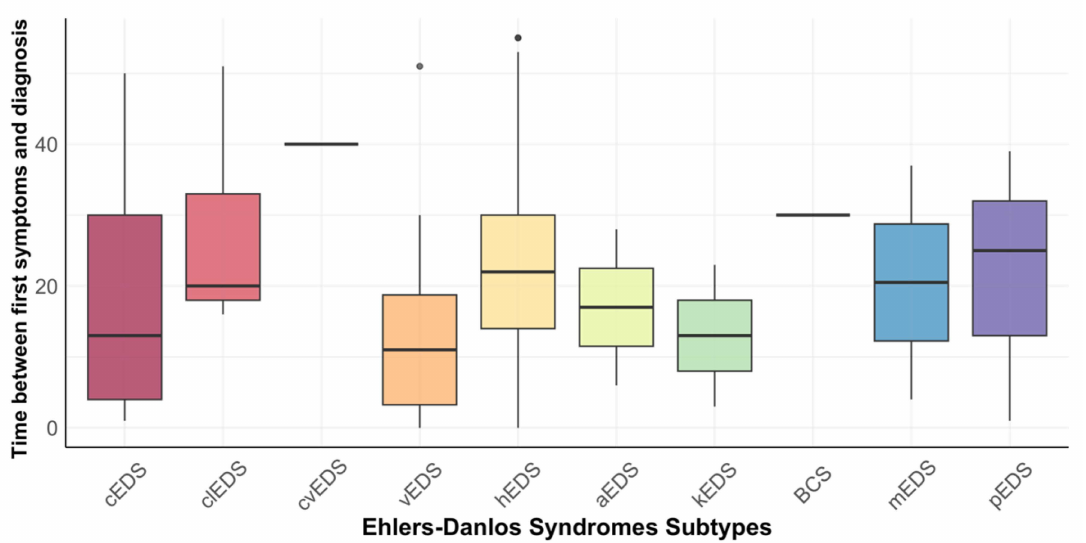
Figure 2. Boxplots for the time between first symptoms and diagnosis in